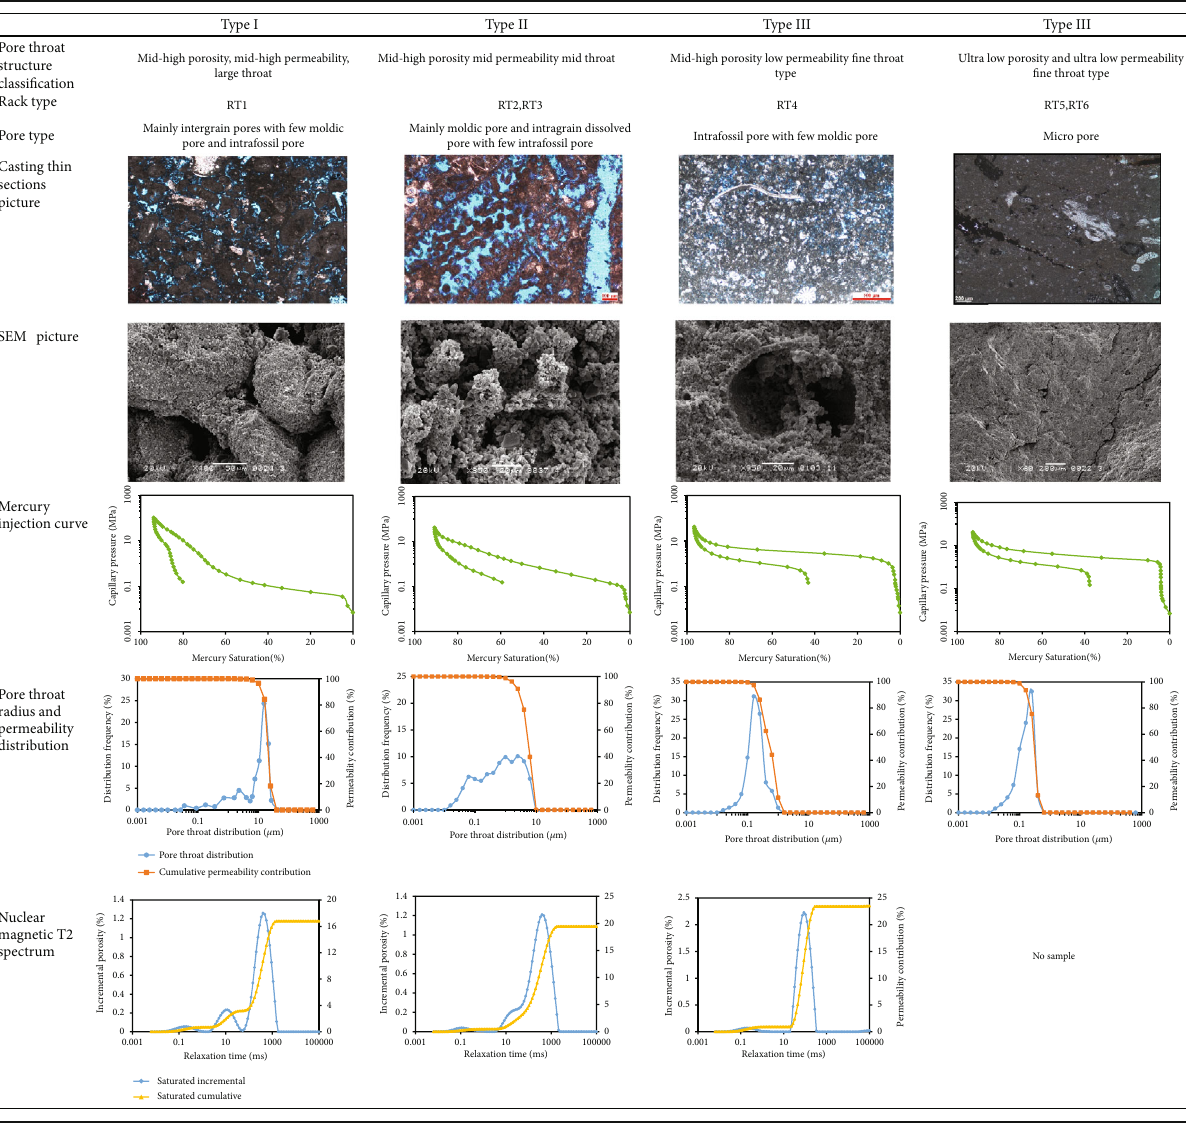
Table 3: Characteristics of each pore structure